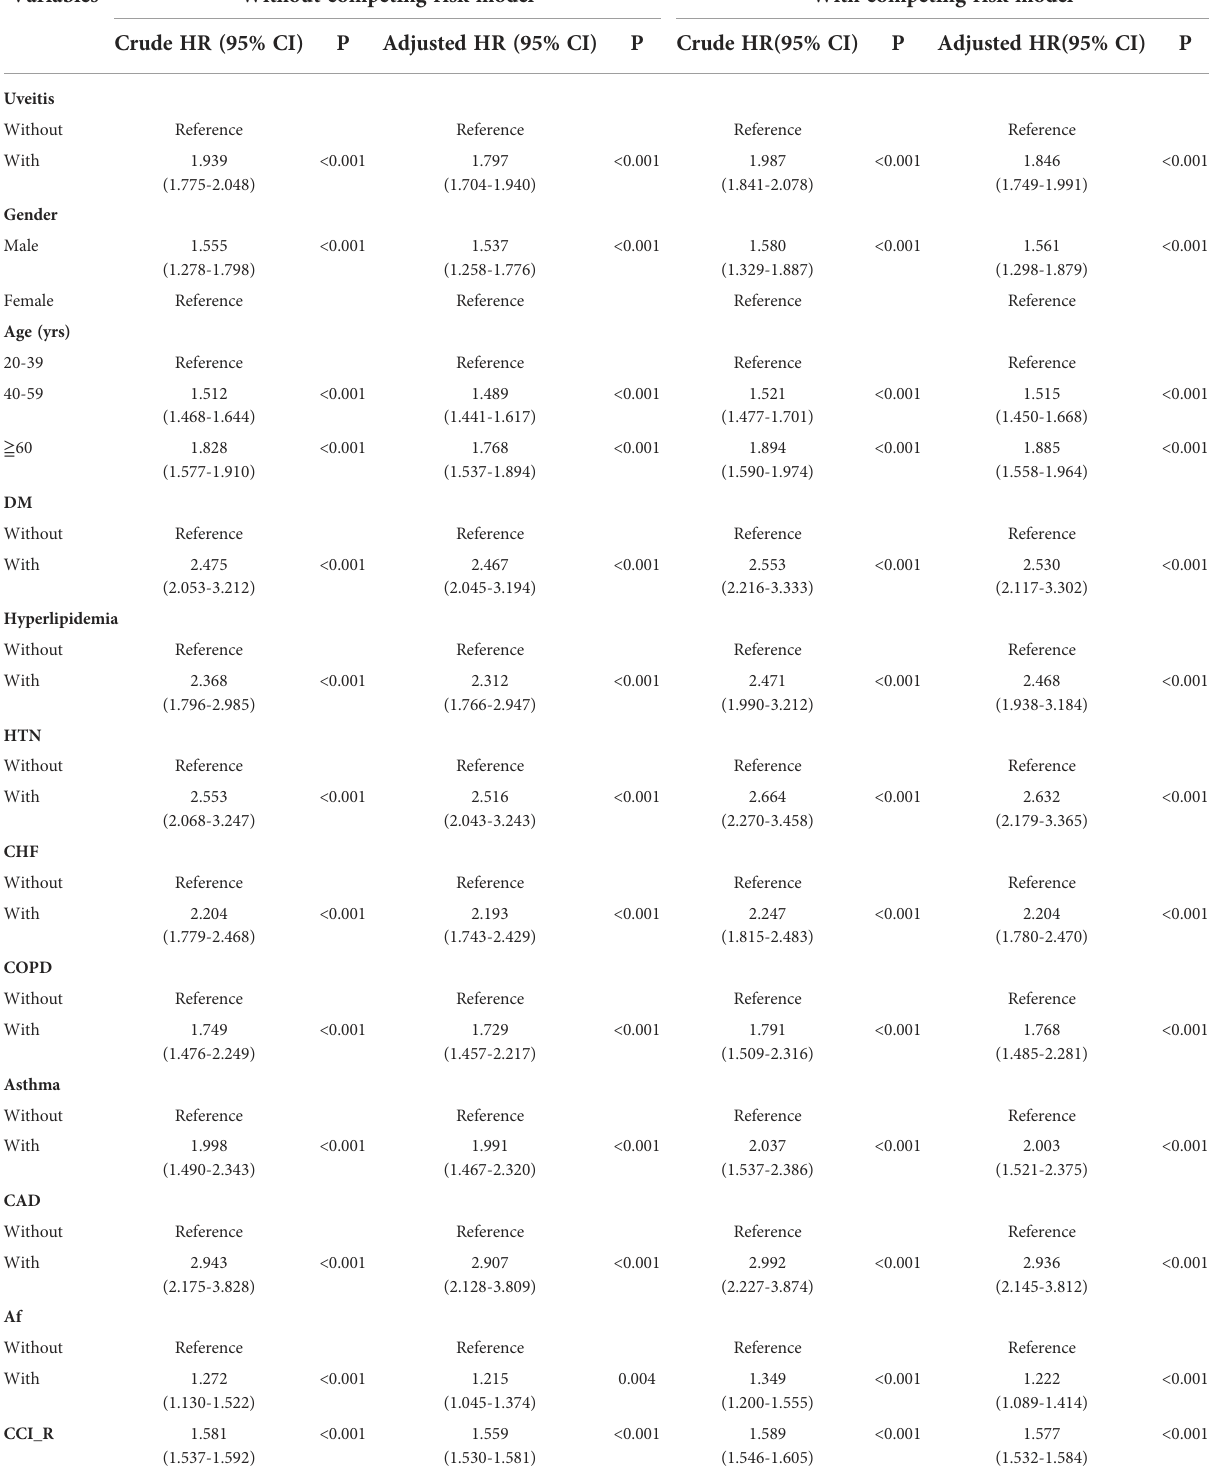
TABLE 2 Risk analysis of stoke by using Cox proportional hazards model with/without Fine & Gray ’ s competing risk